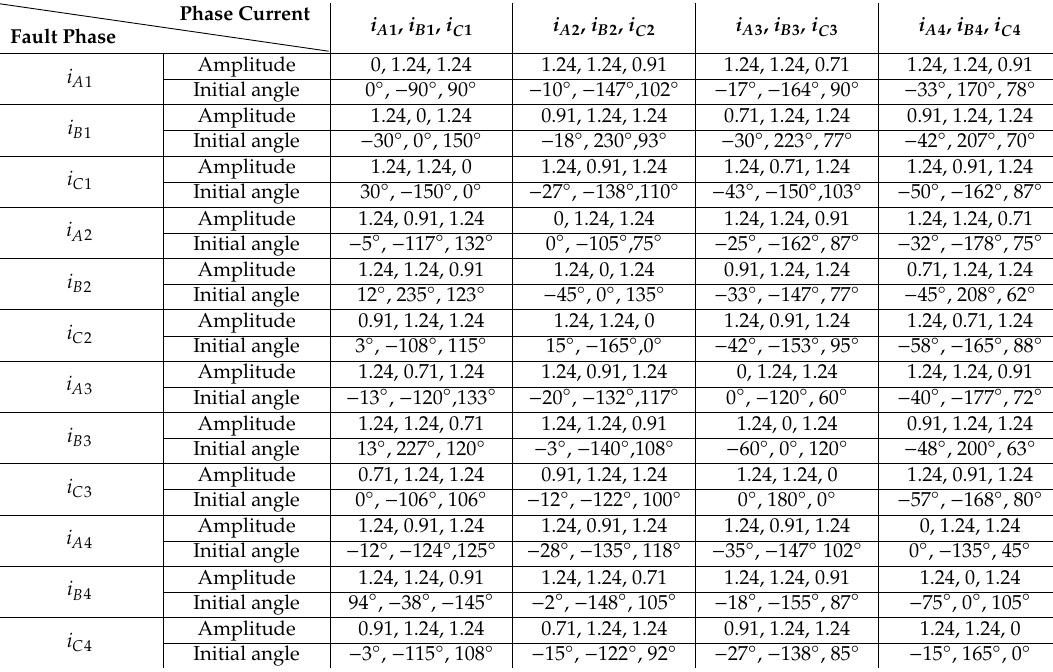
Table 2. Maximum torque output (MTO) fault-tolerant control